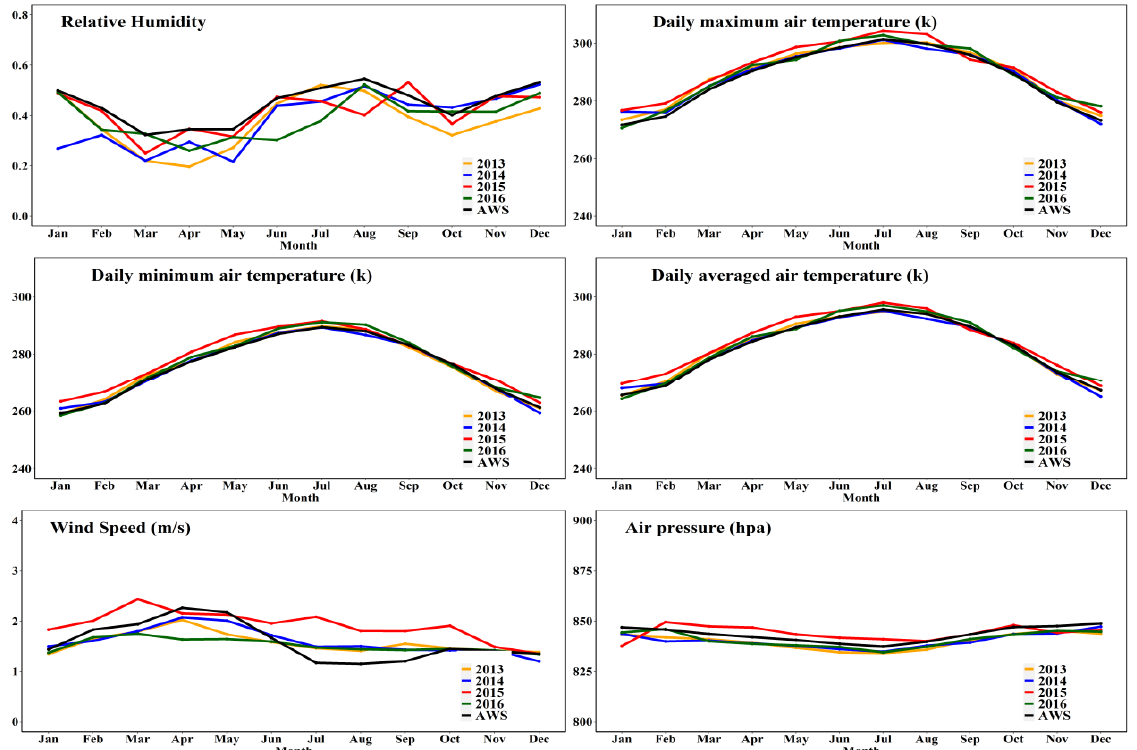
Figure 7. The mean meteorological variables from monthly averaged CMADS daily data from 2013 to 2016 around the AWS station.